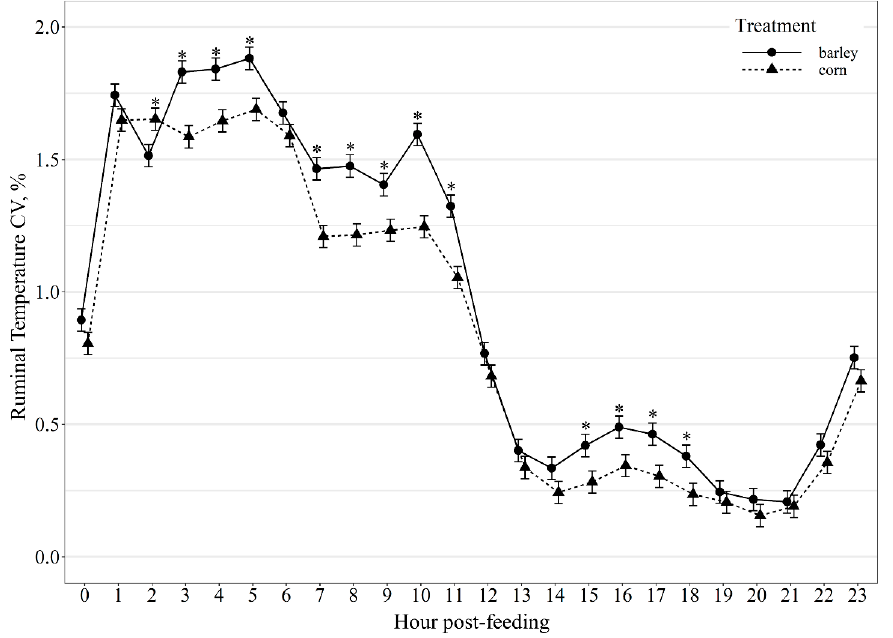
Figure 5. Diurnal ruminal temperature coefficient of variation (CV, %) patterns of beef steers fed once daily (0800) barley- or corn-based feedlot diets. Ruminal temperature CV was influenced by diet × hour post-feeding interaction ( p < 0.01) and differences ( p ≤ 0.05) within hour post-feeding are denoted by